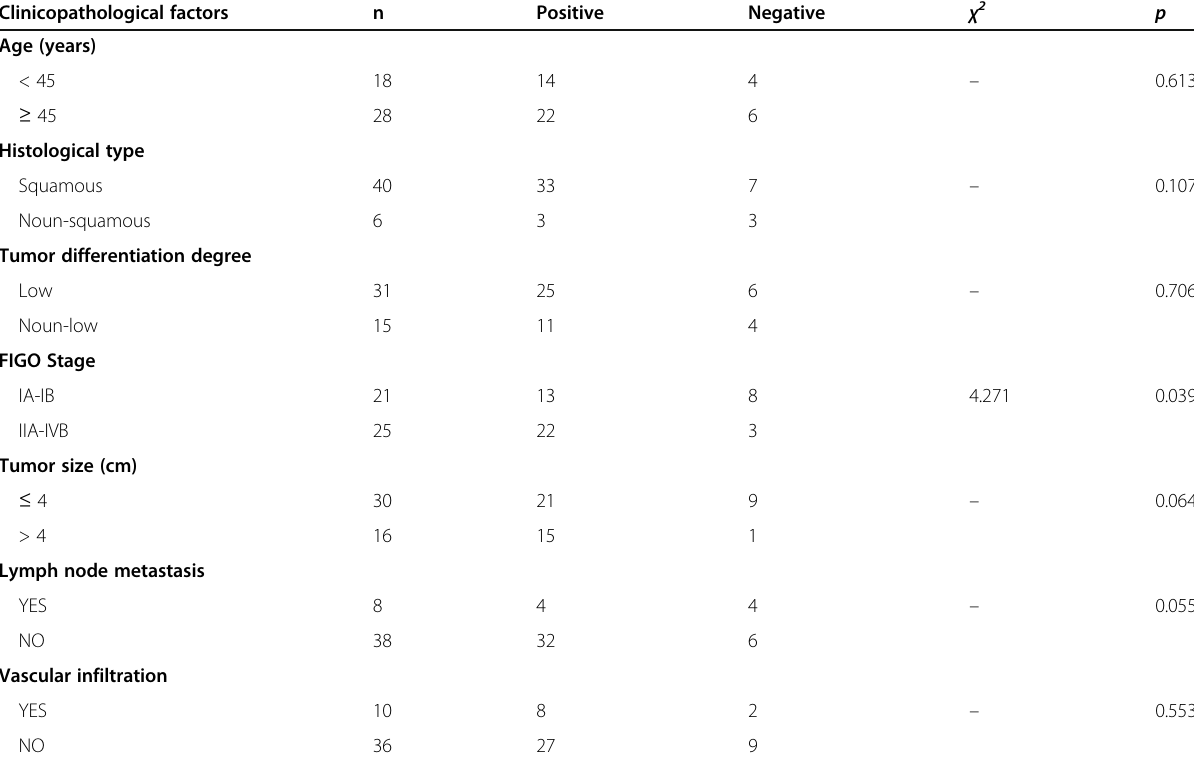
FIGO Federation International of Gynecology and Obstetrics a The statistical method is Fisher